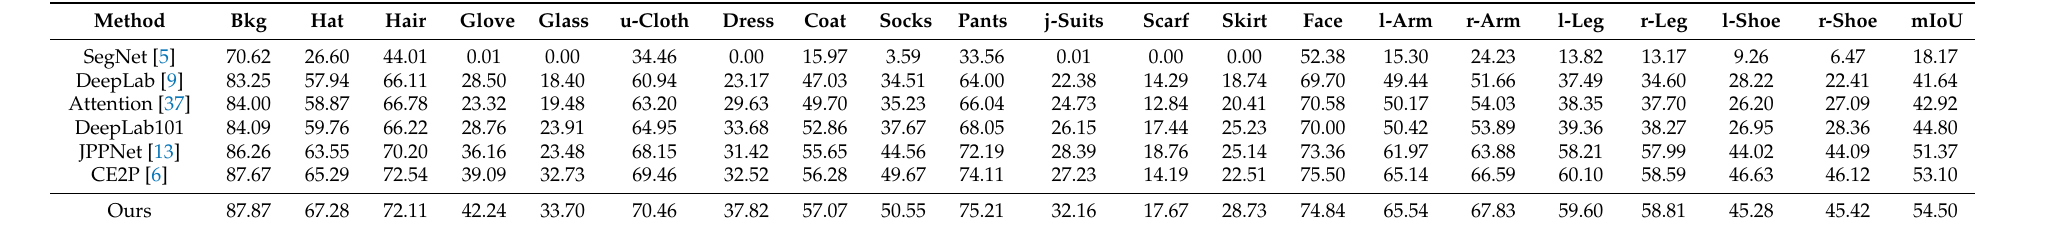
Table 2. Performance comparison in terms of mean pixel Intersection-over-Union (mIoU) with state-of-the-art methods on LIP validation